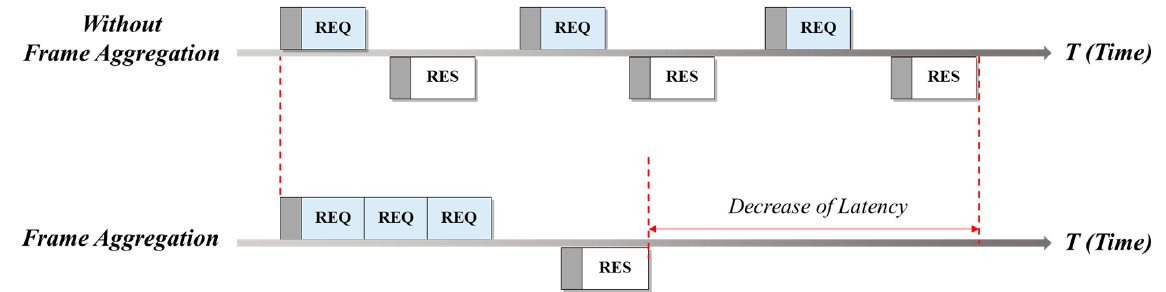
Figure 1. Frame aggregation.